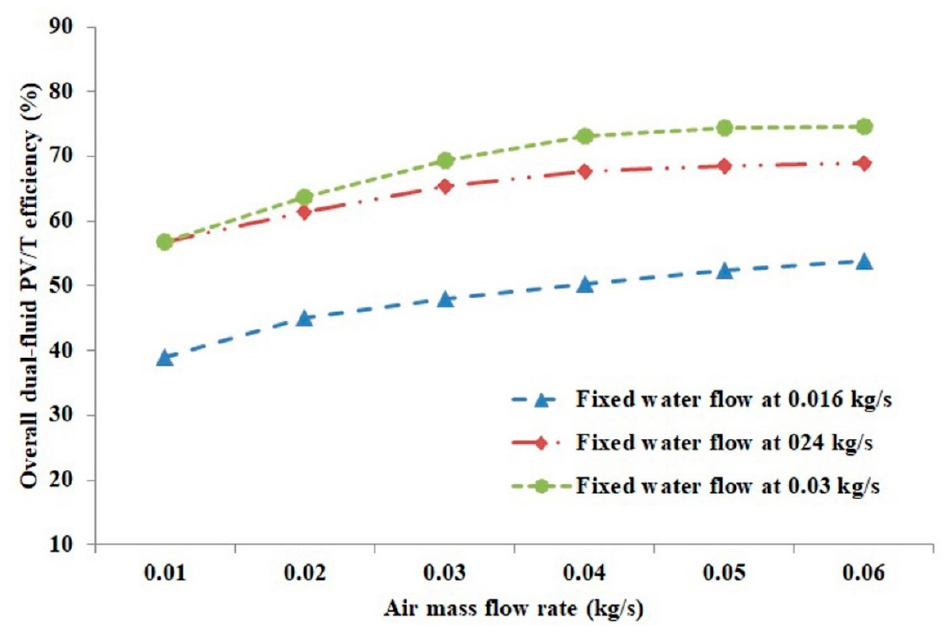
Figure 3. Variations of overall efficiency of the dual-fluid PV/T system at variable air flow rate and fixed water flow rate.